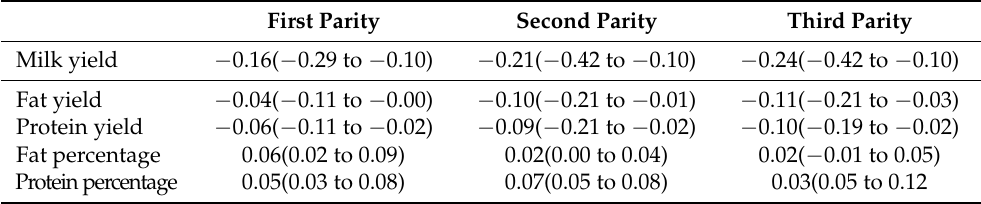
Table 4. Mean (range) permanent environmental correlations between SCS and production traits in the first three parities of Iranian Holstein